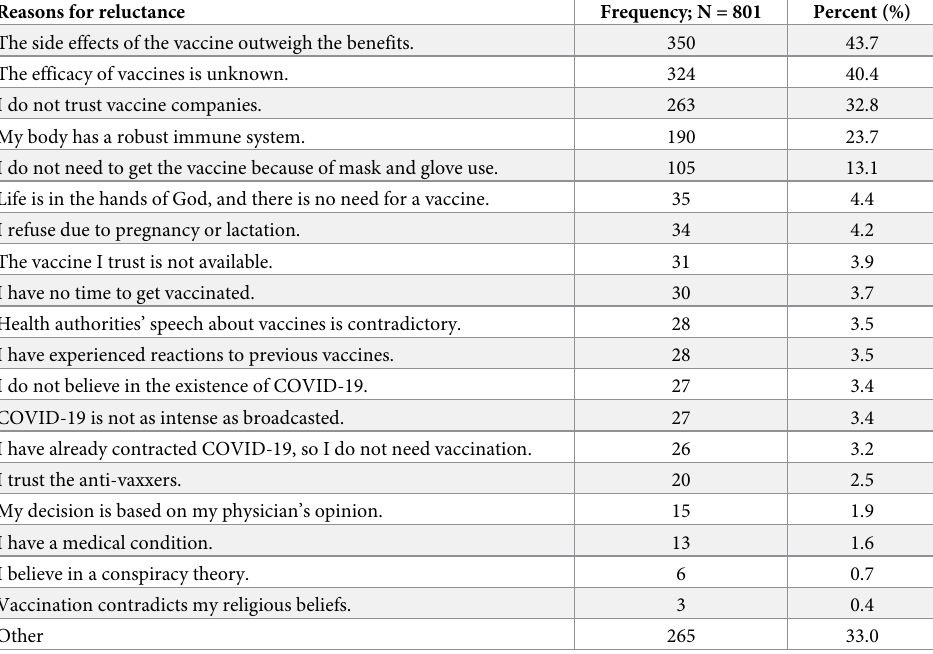
Table 2. Reasons for reluctance toward COVID-19